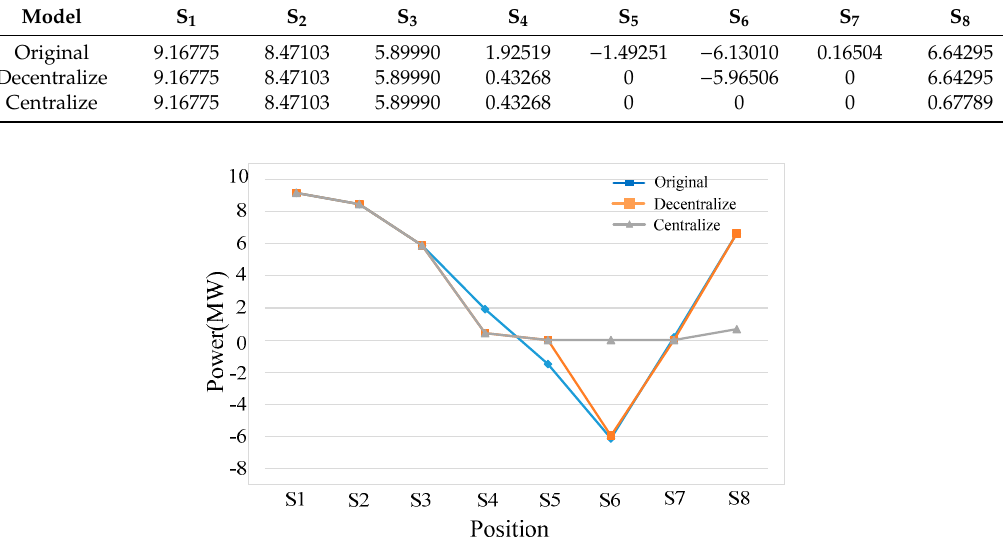
Table 5. Feeder power before and after regulation under case 3 (MW).